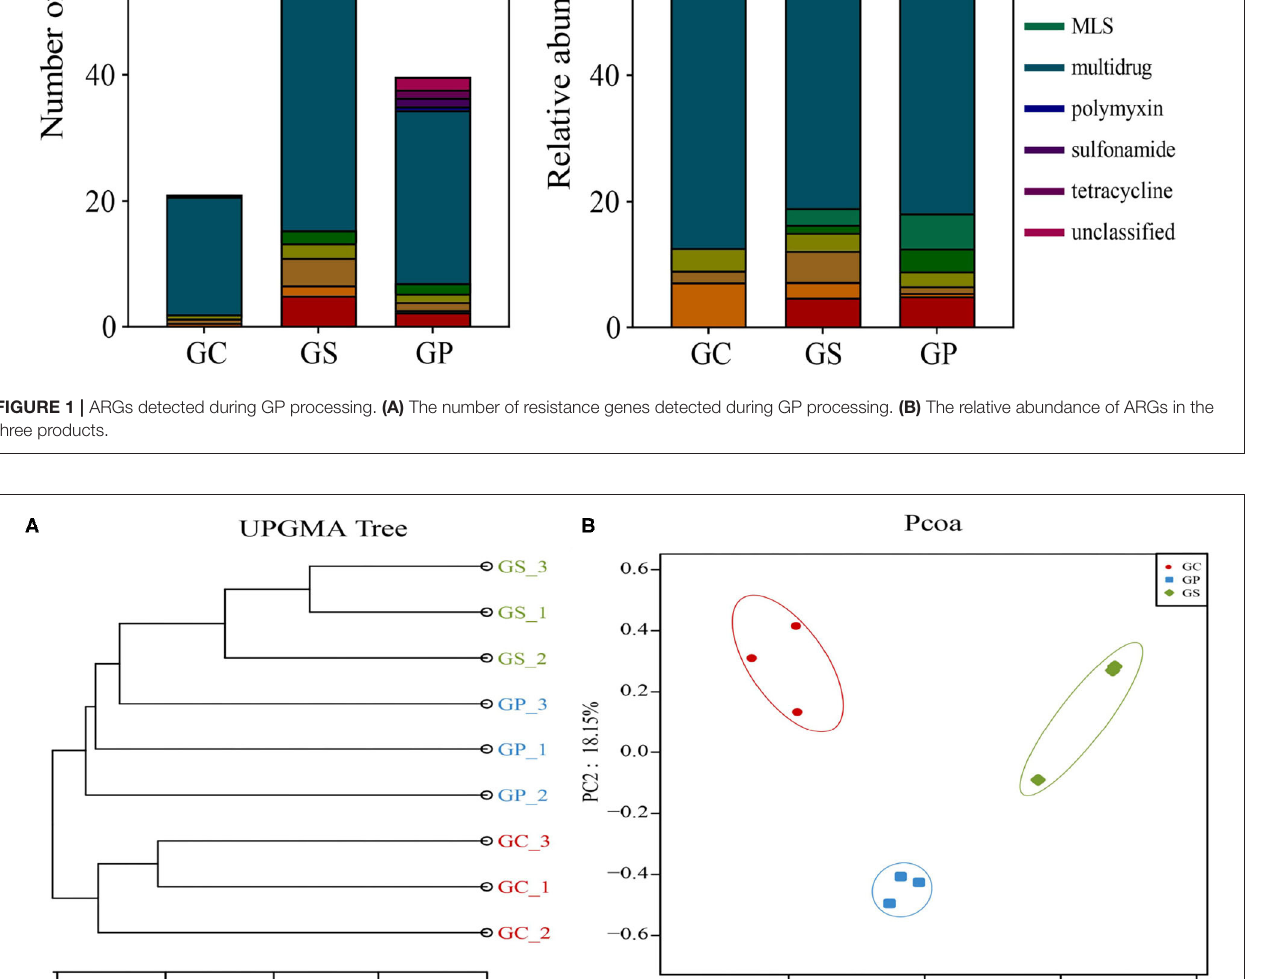
(belonging to polymyxin) was negatively correlated with 52 other ARGs, including 38 multidrugs, four beta-lactams, two chloramphenicols, two tetracyclines, and so on. In GP, sul1 (belonging to sulfonamide) was located in the center of